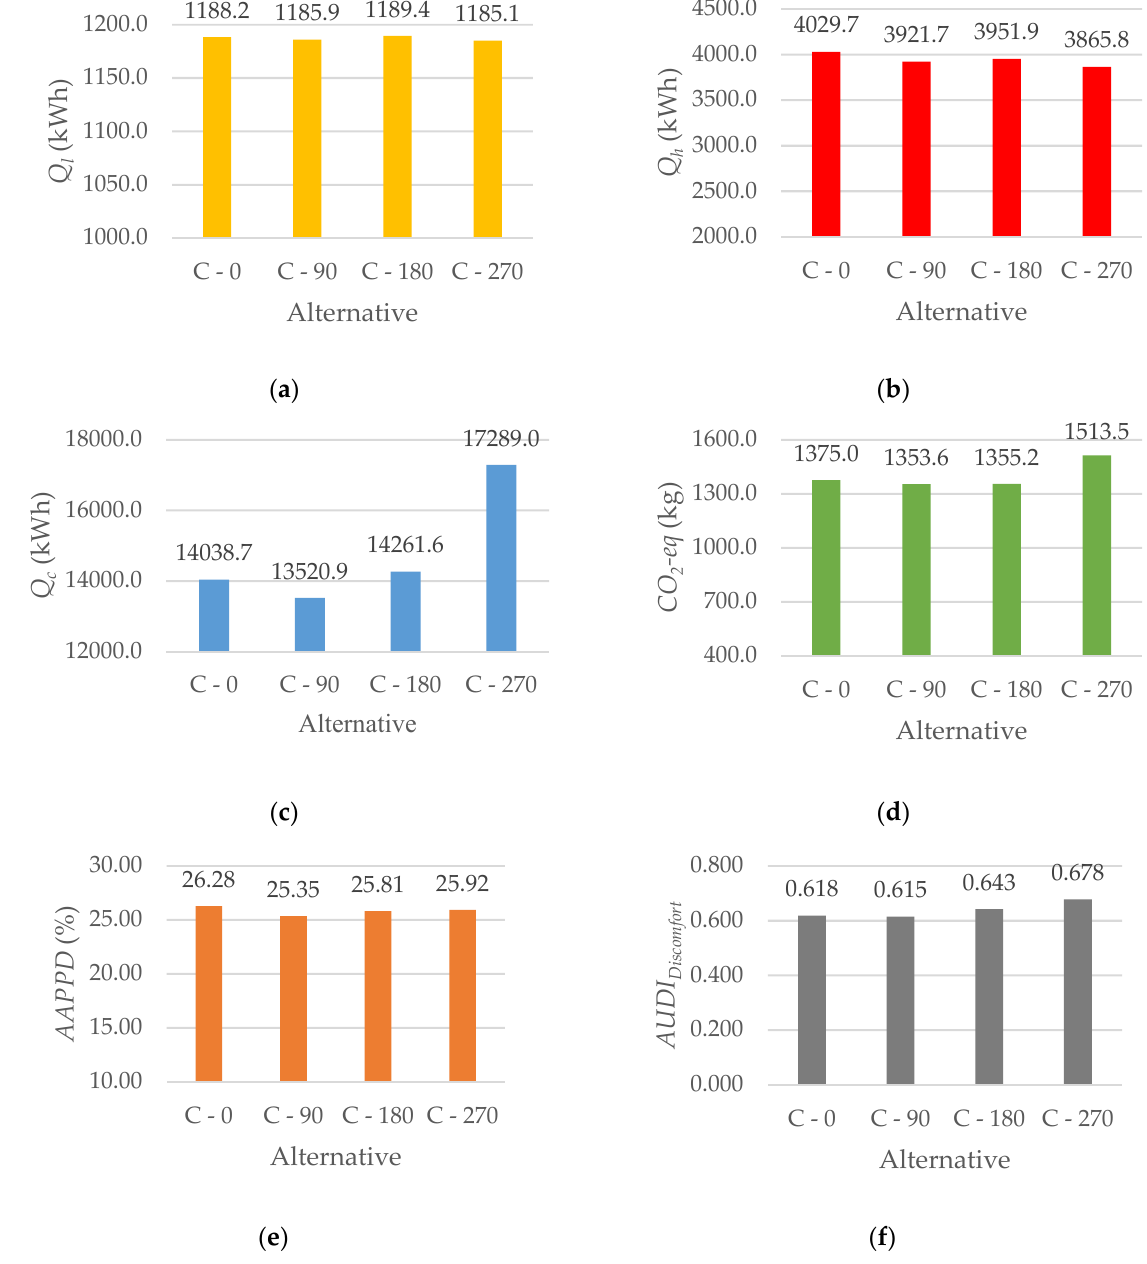
Figure 9. Annual profiles of the considered objective functions for different orientations of the building type C: ( a ) annual profiles of Q l ; ( b ) annual profiles of Q h ; ( c ) annual profiles of Q c ; ( d ) annual profiles of CO 2 -eq ; ( e ) annual profiles of AAPPD ; ( f ) annual profiles of AUDI Discomfort . Table 6. The TOPSIS results for different orientations of the building type C.